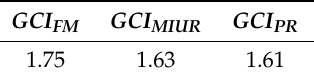
Table 5. Di ff erent values for di ff erent definitions of glass ceiling index (author’s elaboration on MIUR data